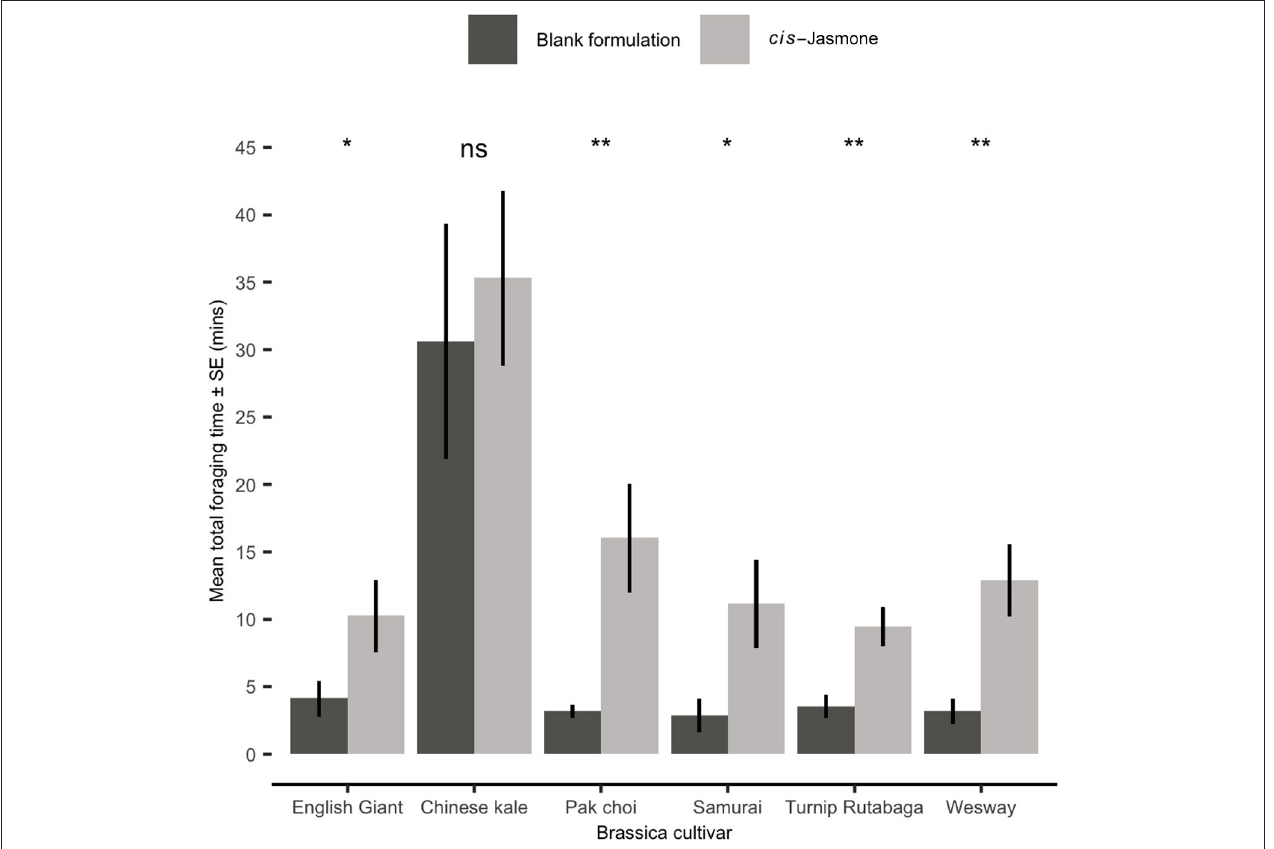
FIGURE 4 | Mean total time spent foraging (Mean ± SE) by Diaeretiella rapae on blank formulation (control) and cis- jasmone treated plants ( n = 10). Brassica cultivars capped with “ns” do not show a significant difference between control and CJ treatment while asterisks denote differing levels of statistical significance: * < 0.05 and ** < 0.01 (two-sample t